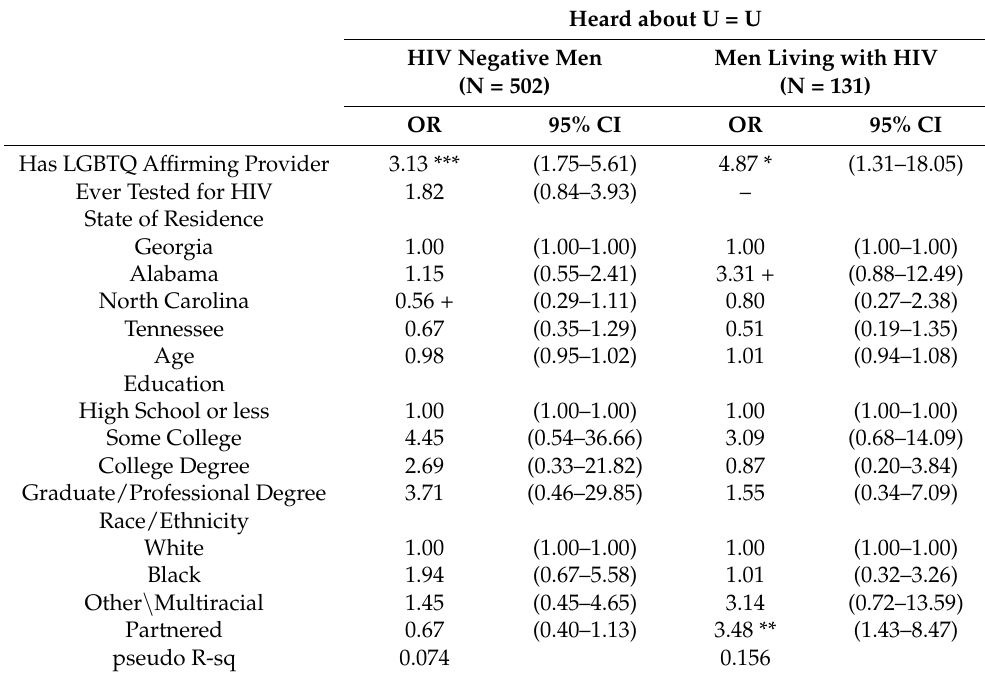
Table 4. Estimates of U = U awareness among a sample of midlife and older gay and bisexual men in the US south by HIV status,